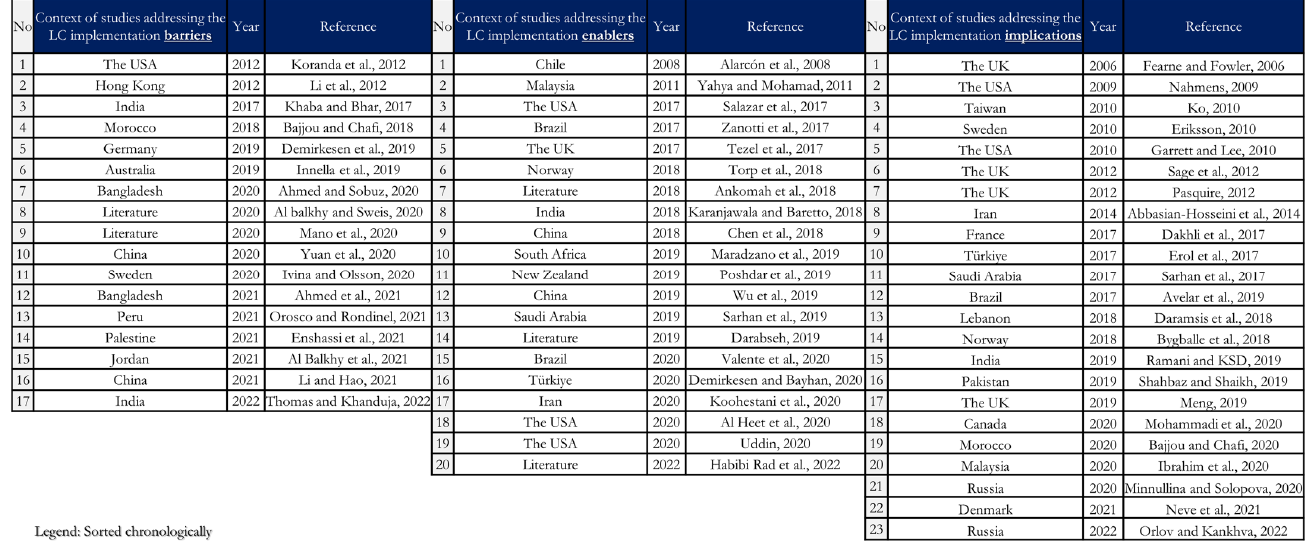
Figure 2. Contexts of studies addressing barriers, enablers, and implications of implementing LC .